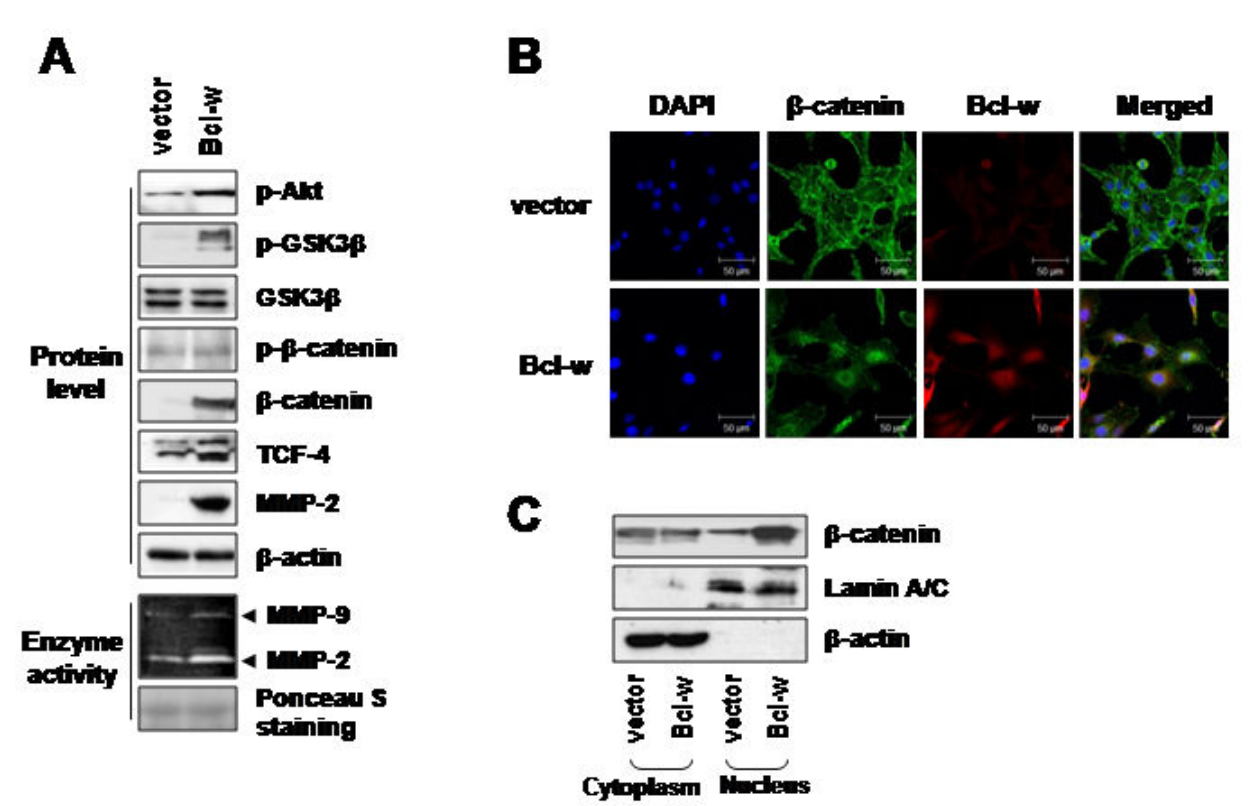
Figure 4. Bcl-w enhances transloation of β-catenin into the nucleus in U251 glioblastoma cells. A , levels of p-Akt, p-GSK3β, GSK3β, p-β-catenin, β-catenin and TCF-4 in cell lysates were compared by Western blotting using β-actin as a loading control. Conditioned media were prepared by incubating the vector and Bcl-w transfectants in serum-free medium for 24 hours. MMP-2 and MMP-9 activities were compared using zymography. Protein loading volumes were verified with Ponceau S staining. B , levels of β- catenin protein that translocated into the nucleus and Bcl-w protein in vector- or Bcl-w-transfected U251 cells were examined using confocal microscopy. Cells were stained with anti-β-catenin (green) or anti-Bcl-w (red) antibody, followed by nuclear staining with DAPI (blue). Scale bar, 50 µm. C , after separation of cells into cytoplasm and nuclear fractions for the indicated transfectants, each fraction was subjected to Western blotting with anti-β-catenin, anti-Lamin A/C (nucleus marker) and anti-β-actin (cytoplasm marker)